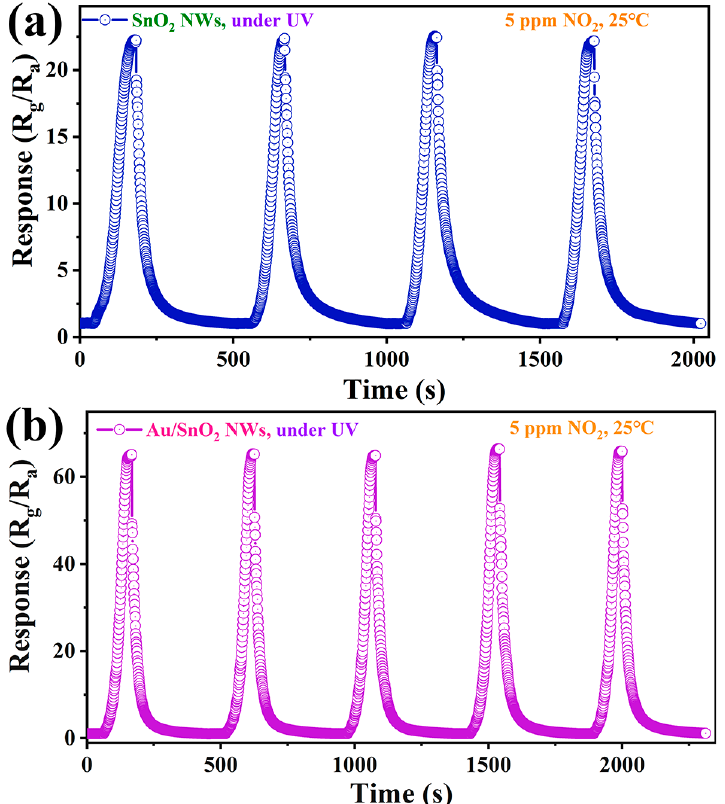
Figure 8. The cyclic response–recovery curves of sensors based on ( a ) SnO 2 and ( b ) Au/SnO 2 NWs to 5 ppm NO 2 at RT under UV irradiation (0.42 mW/cm 2 ).